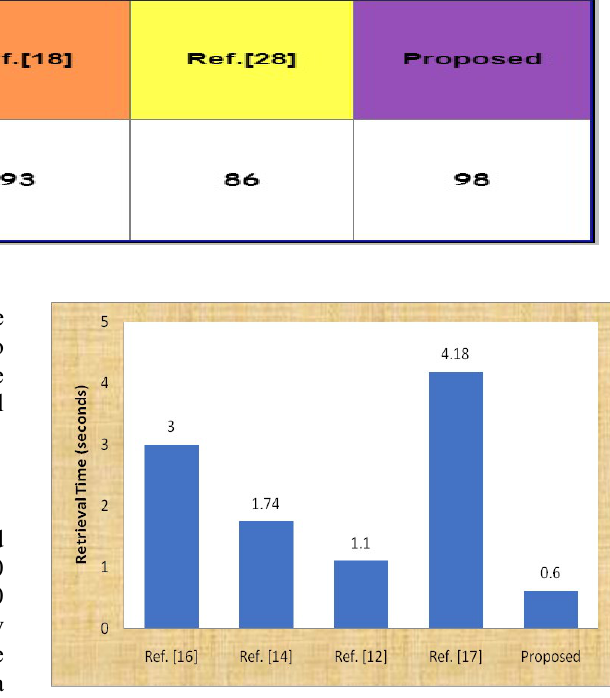
Figure 7. Comparison of retrieval time of the